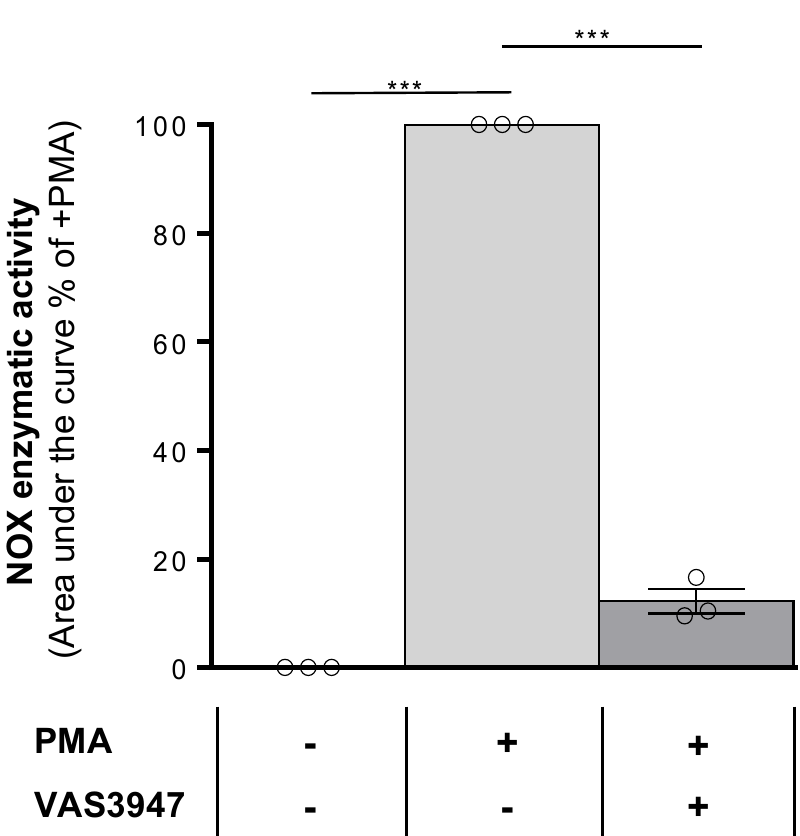
Figure 2. Effect of VAS3947 on phorbol 12-myristate 13-acetate (PMA)-induced NOX activity in THP-1 cells. PMA injection induced NOX activity in THP-1 cells, while the addition of VAS3947 at 4 µM blocked most of this induction. Results are shown as the mean ± SEM of n = 3 independent experiments. Student’s t -test was performed comparing each treated condition to the corresponding control counterpart (*** p < 0.001).